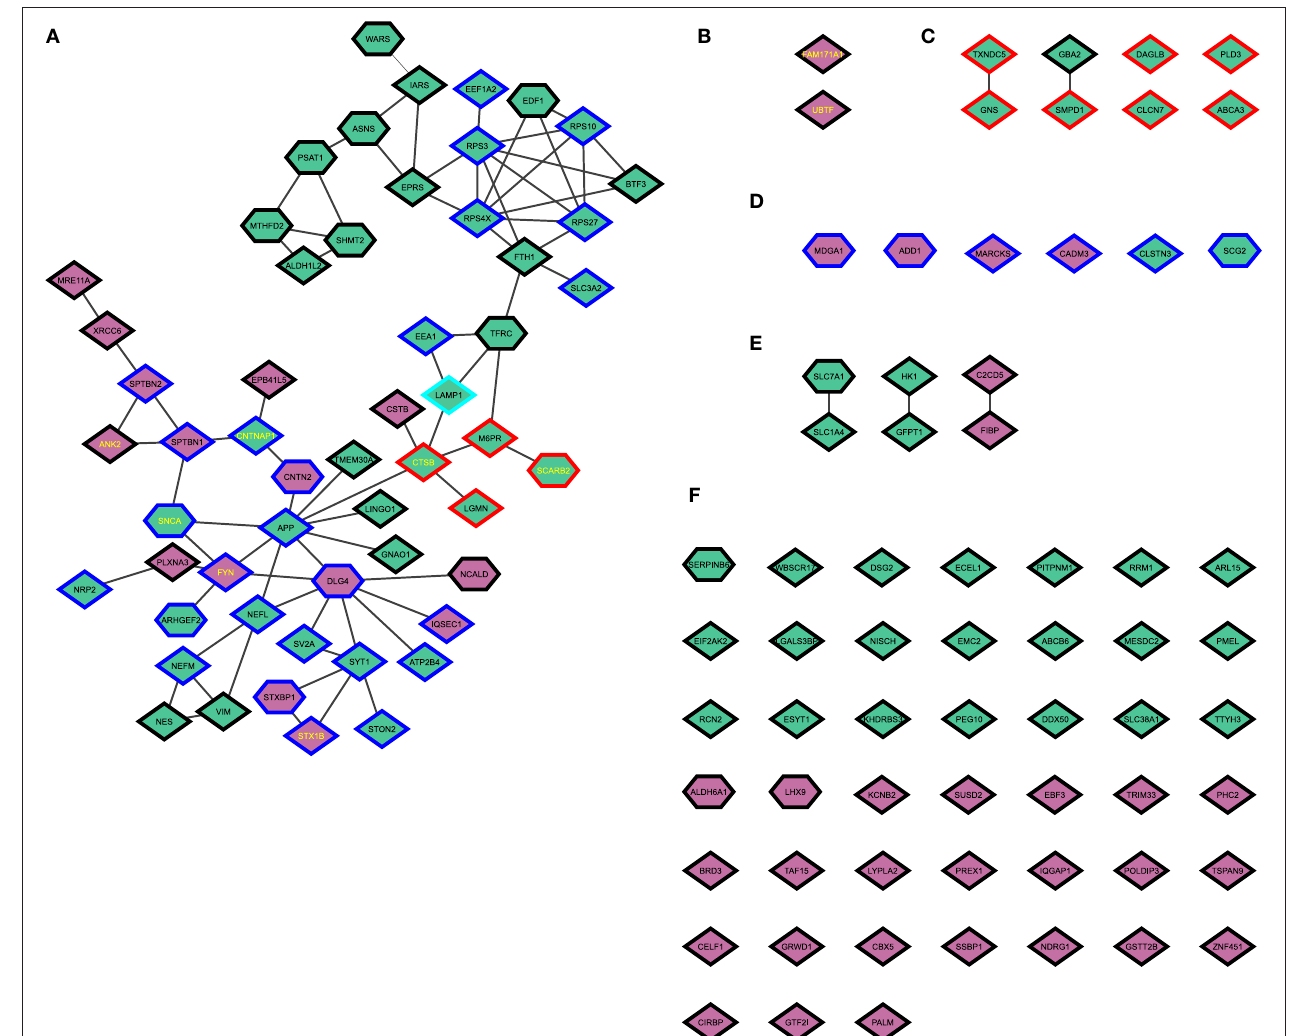
FIGURE 5 | STRING network analysis. (A) Interaction network of all differentially regulated proteins with a high confidence level (0.7). (B) Protein associated with PD without interactors. (C) Proteins associated with the lysosome. (D) Proteins associated with synapses. (E) Proteins with one interactor. (F) Proteins without interactors. Diamonds show proteins only differentially regulated in the proteome. Hexagons indicate proteins with corresponding differentially regulated transcripts. Upregulated proteins are shown in green; downregulated proteins are shown in purple. Red borders indicate proteins with association with the lysosome. Blue borders indicate proteins with association with synapses. A turquois border indicates association with synapses and the lysosome. A yellow label indicates genes that were previously associated with PD in the recent GWAS